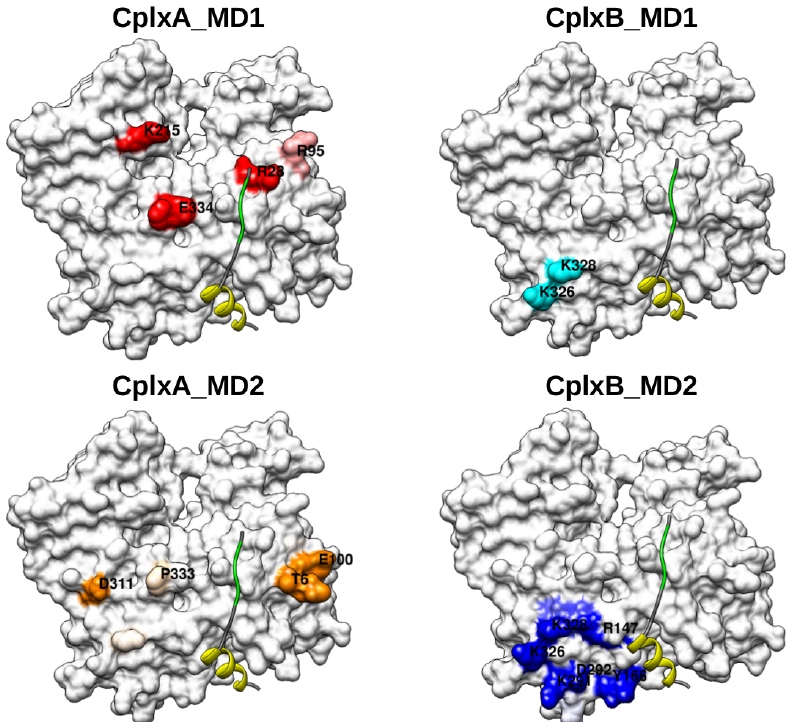
Figure 8. Actin residues distant by less than 4 Å from N-WASP segments 28 NSRPVS 33 or 56 GQESTP 61 in CplxA_MD1 (red), CplxA_MD2 (orange), CplxB_MD1 (cyan), and CplxB_MD2 (blue). As a reference, yellow and green ribbons represent the helical region and the conserved sequence LKSV of the second WH2 motif observed in structure 2VCP